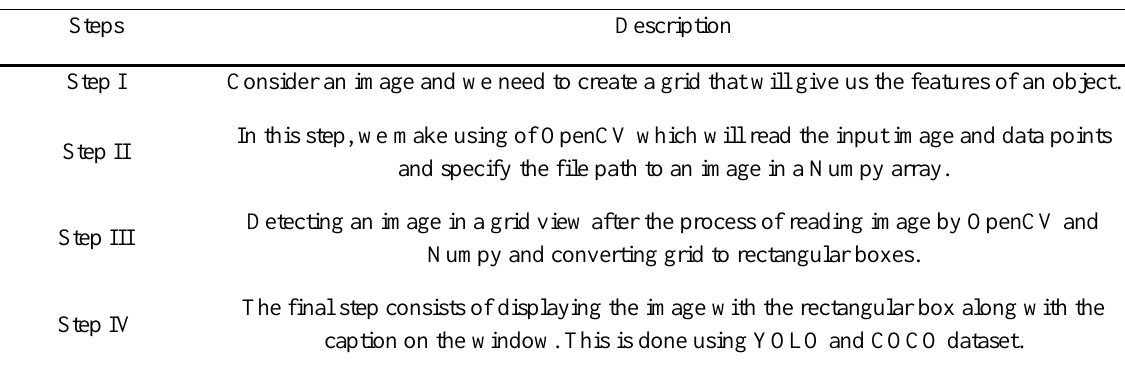
Table 2. Algorithm for proposed